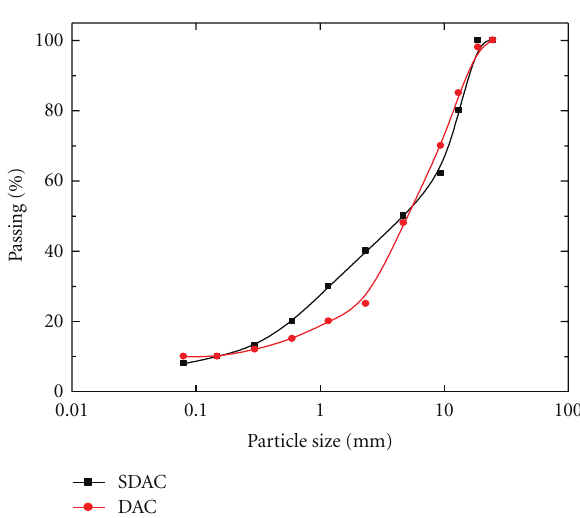
Figure 1: Gradation curves SDAC and DAC samples